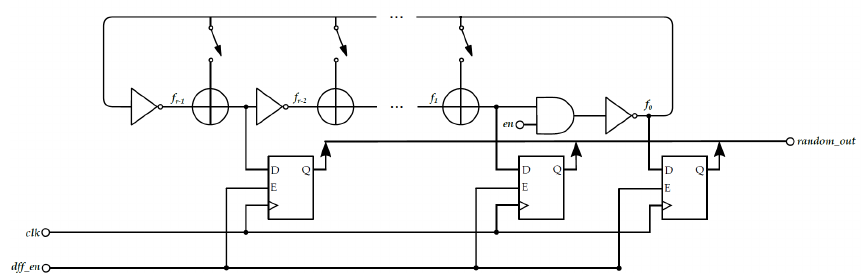
Figure 12. Galois Ring Oscillator with state sampling. The output bus is XORed together to form a 1-bit output in the higher